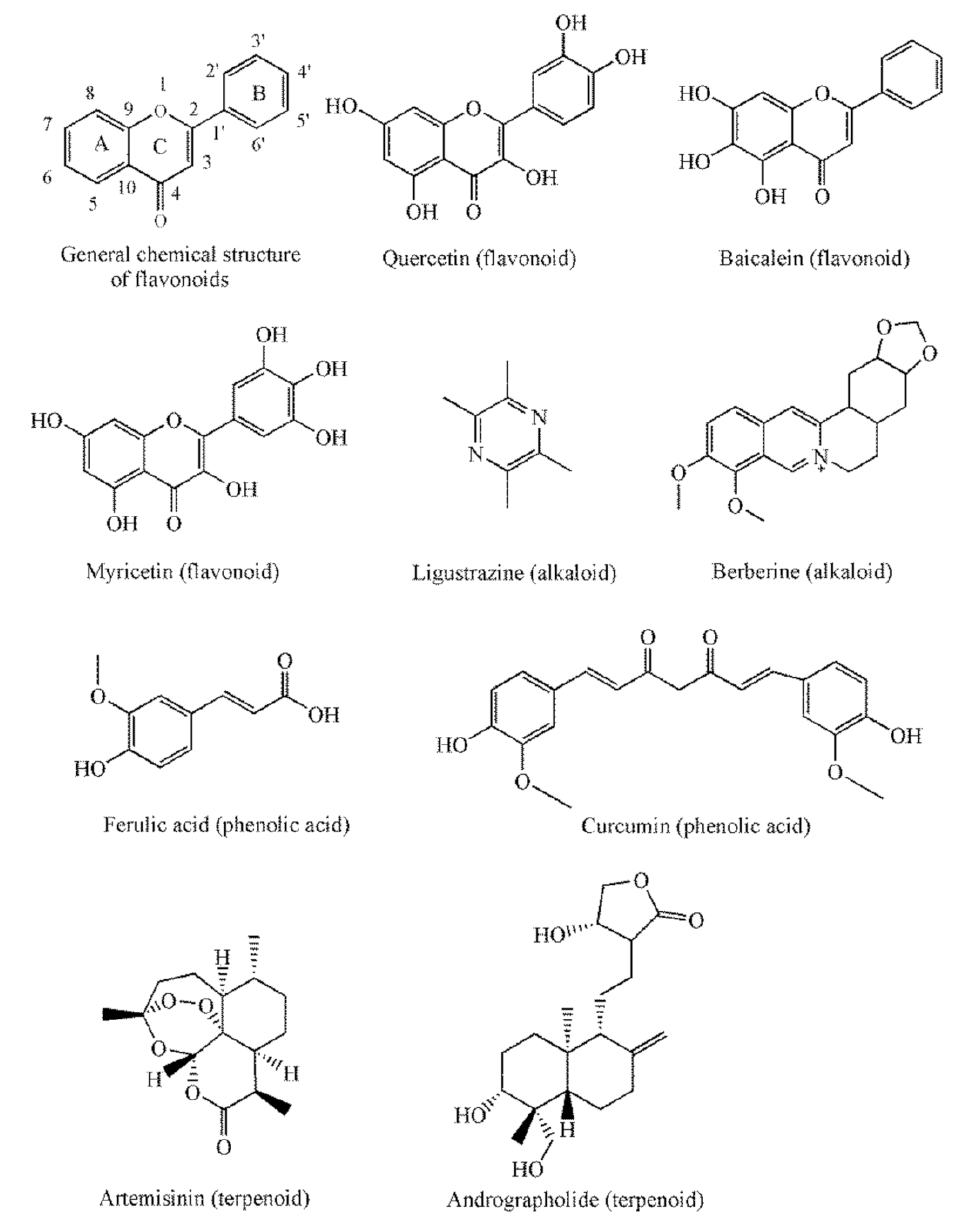
Figure 2. The representative compounds of flavonoids, alkaloids, phenolic acids and terpenoids in this